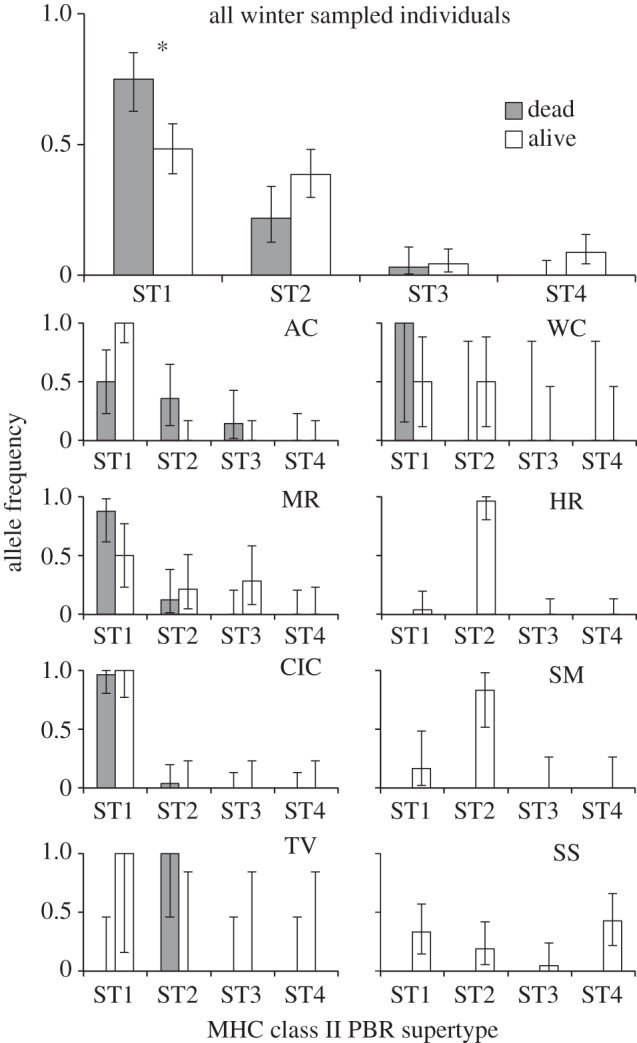
MHC supertype allele distributions for individuals sampled alive (white bars) versus dead (grey bars) across all individuals sampled in winter (upper panel) and within each population (lower panels). Error bars represent 95% binomial confidence intervals for proportions. Significantly different supertype frequencies between alive versus dead frogs are show with asterisks. Population name abbreviations follow figure 1.